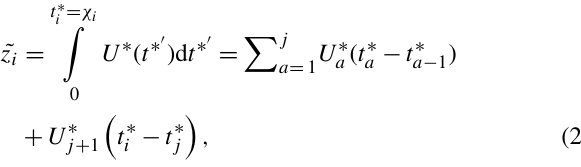
Figure 4. Comparison between the analytic forward model and a numerical model for the evolution of a river long profile, with drainage area set by Hack’s law, A = k a ( L − x ) h . The model parameters are n = 3, K = 2 × 10 − 11 m − 1 . 7 a − 1 , m = 1 . 35, k a = 3 . 5 and h = 1 . 7. The time (d t ) and space (d x ) steps in the numerical model are 10a and 10m, respectively. The applied uplift rate history is U 0 = 0 . 10mma − 1 prior to 0.8Ma, U 1 = 0 . 5mma − 1 between 0.5–0.8Ma and U 2 = 1 . 0mma − 1 between 0.0–0.5 Ma. L , total river length, is 6km (hillslope length is 1km). The analytic (colored, solid) and numerical solutions (black, dashed) match in the x − z (a) and χ − z (b) domains. Panel (c) depicts the river χ − z long profiles offset in elevation, demonstrating knickpoint merging dynamics. Knickpoint kp 1 formed at 0.8Ma, as a response to the increase in the uplift rate from U 0 to U 1 . Knickpoint kp 2 formed at 0.5Ma, due to uplift rate increase from U 1 to U 2 . At ∼ 0 . 2Ma, kp 1 merged with kp